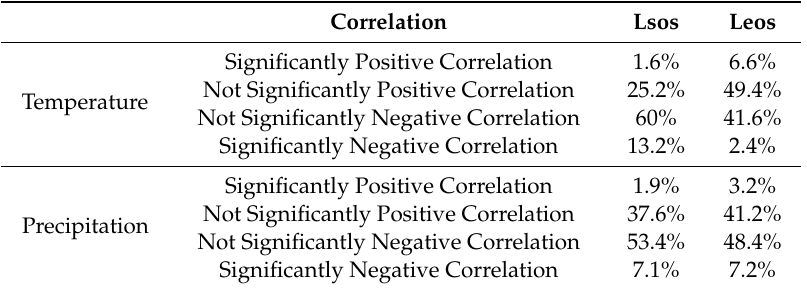
Table 1. Proportions of partial correlation coefficients between the SOS (EOS) and mean temperatures and accumulated precipitations during Lsos, i.e., length of the preseason for SOS (or Leos, i.e., length of the preseason for EOS) for significantly positive correlations ( R < 0.4974), not significantly positive correlations ( R > 0.4974), not significantly negative correlations ( R < − 0.4974), and significantly negative correlations ( R < − 0.4974). Values of R = ± 0.4974 correspond to p -values of 0.05, according to the two-tailed Student’s t -tests.